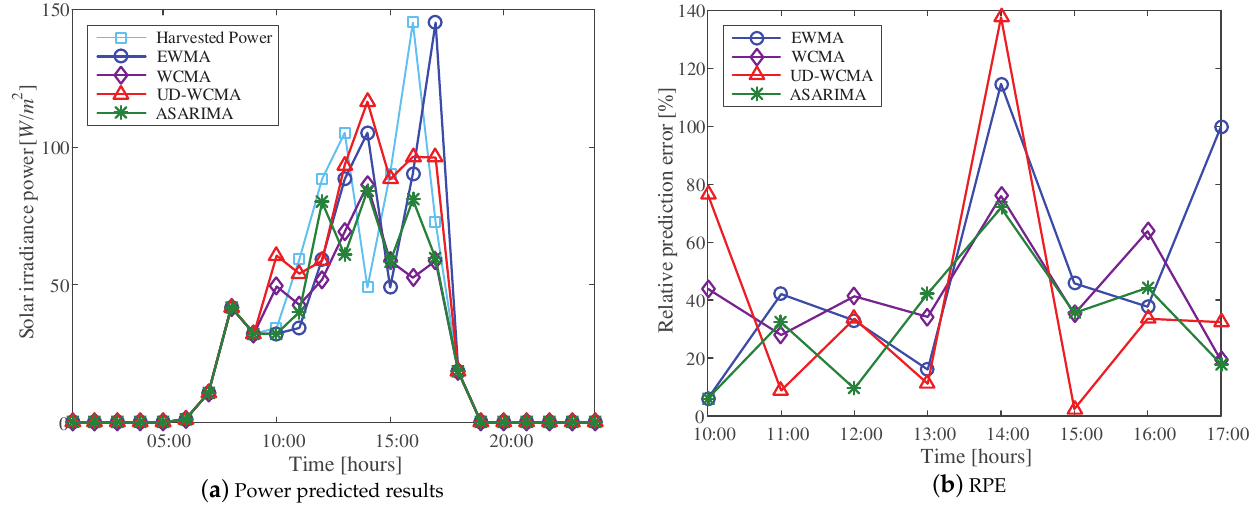
Figure 7. Power predicted and prediction error for 15 April 2018.